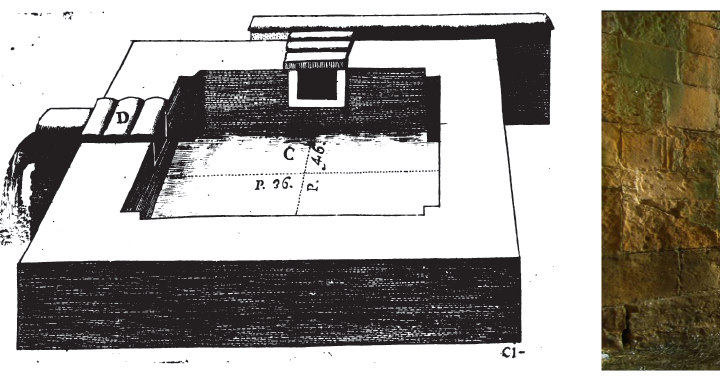
Figure 7. Roman cistern in the ancient town Aptera, Chania, Crete: ( a ) Drawing of cistern from Raffaele Fabretti [17] and ( b ) Interior view of the three-aisled vaulted cistern (of about 3000 m 3